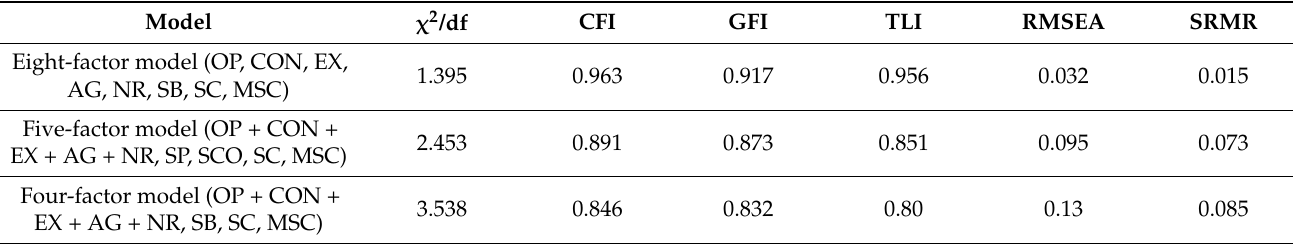
Table 4. Results of Confirmatory Factor